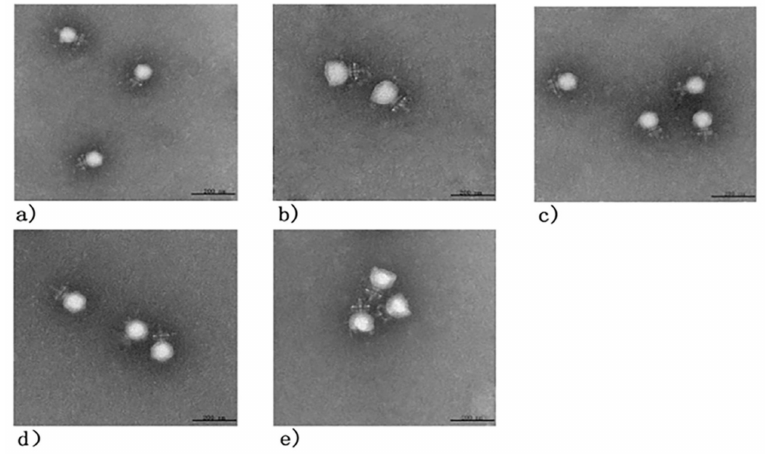
Figure 2. Electron micrograph of S. aureus phages isolated from clinical mastitis. All the phages have an isometric head of 37.5 ± 3 nm in diameter and a non-contractile tail with a length of 15 ± 3 nm, and a baseplate structure at the tip of the tail. ( a ) Phage 4086-1; ( b ) Phage 4086-2; ( c ) Phage 4086-3; ( d ) Phage 4086-4; ( e ) Phage 4086-6. Table 1. Host range of S. aureus phages isolated from clinical mastitis by spot test. Phage Phage 4086-1